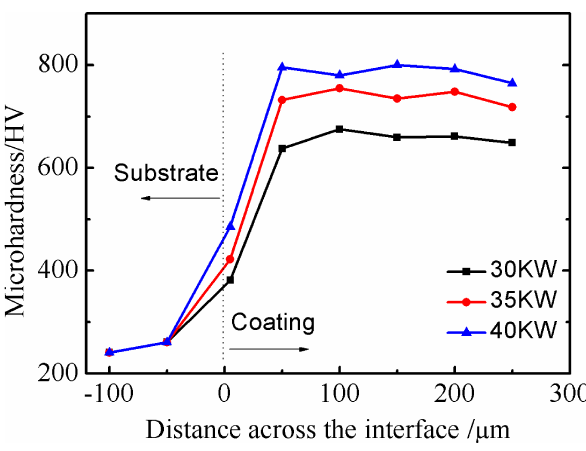
Figure 4: Micro-hardness profiles of plasma-sprayed Fe-based amorphous coatings.